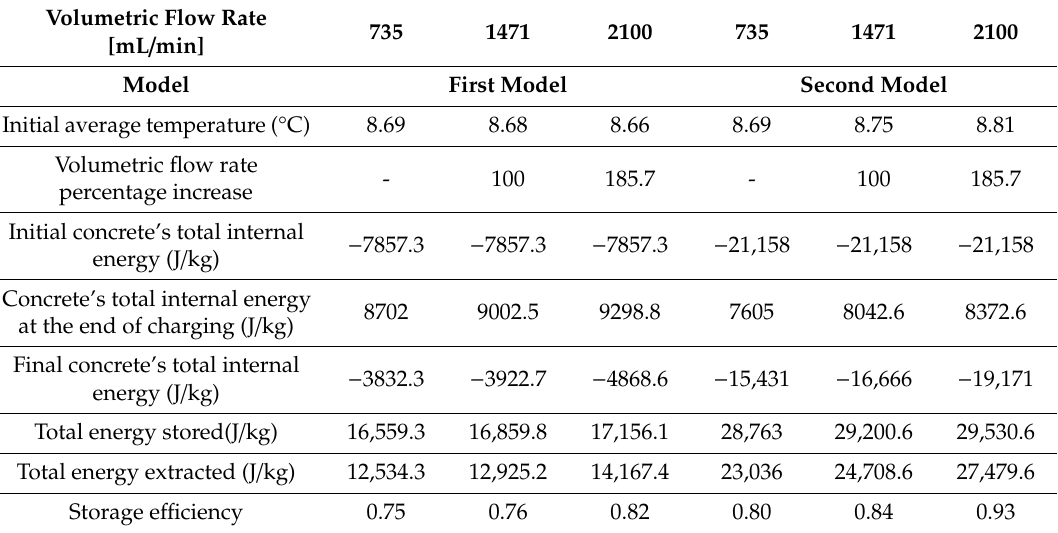
Table 5. Flow rate and PCM e ff ect on the storage capacity and storage e ffi ciency of both